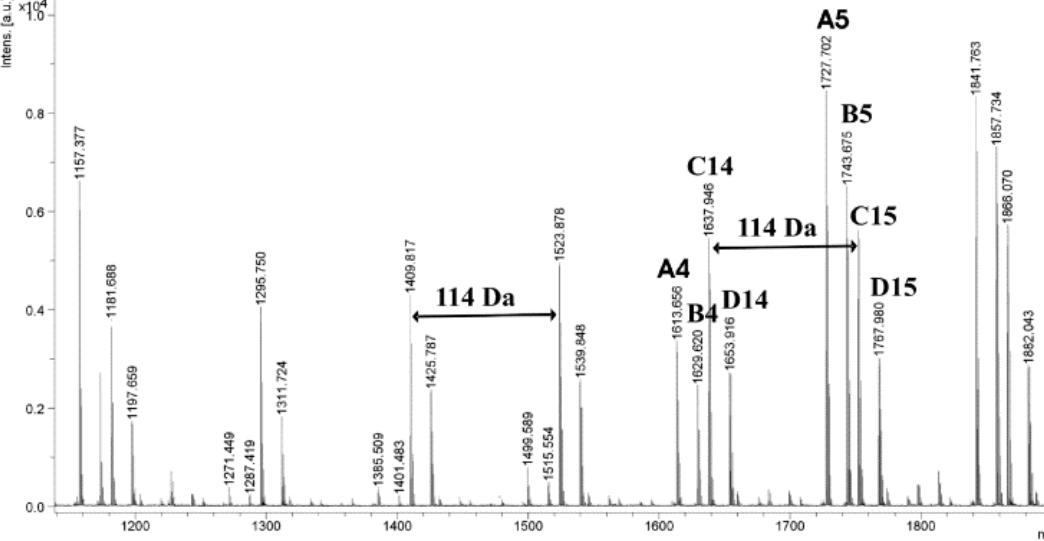
β -CD / PCL100 polymer obtained at 100 ◦